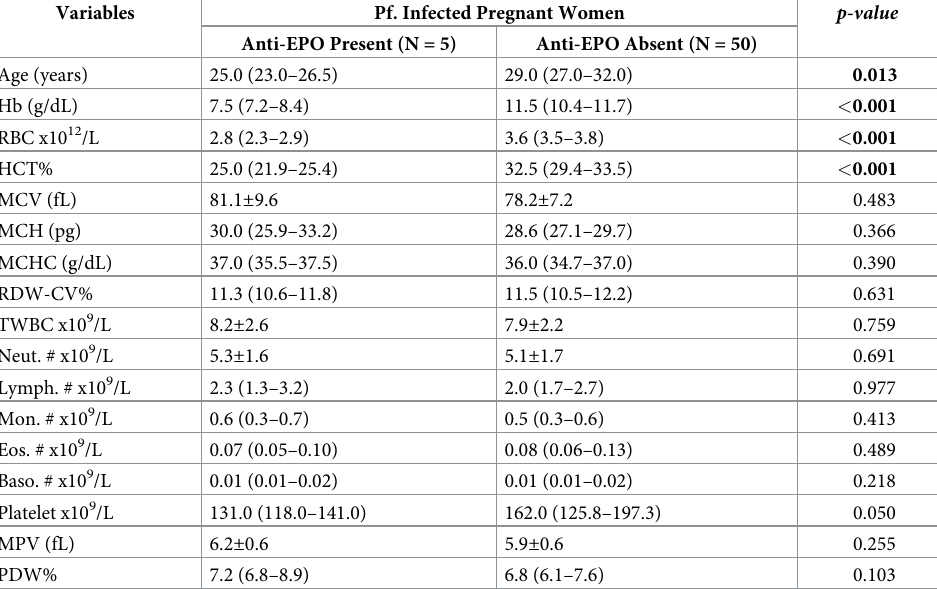
Table 3. Haemogram of the P . falciparum- infected pregnant women stratified by the presence or absence of serum anti-erythropoietin antibodies. Variables